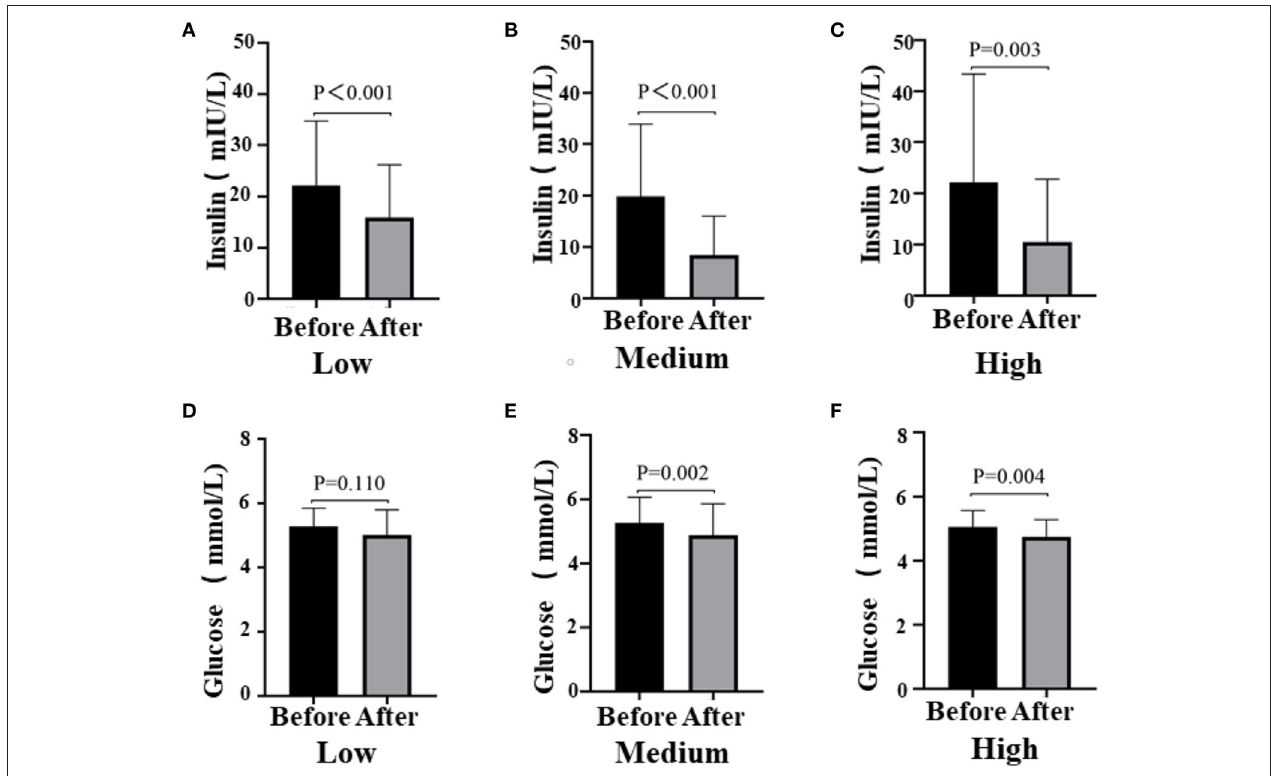
FIGURE 3 | Fasting blood glucose levels ( A , Low dose group; B , Medium dose group; C , High dose group) and insulin levels ( D , Low dose group; E , Medium dose group; F , High dose group) before and after the intervention in all three groups, respectively. Black means glucose or insulin plasma concentration (mmol/l, mIU/l) before the intervention, gray means glucose or insulin plasma concentration after the intervention; paired t -test used to test the difference before and after the intervention in the three groups.